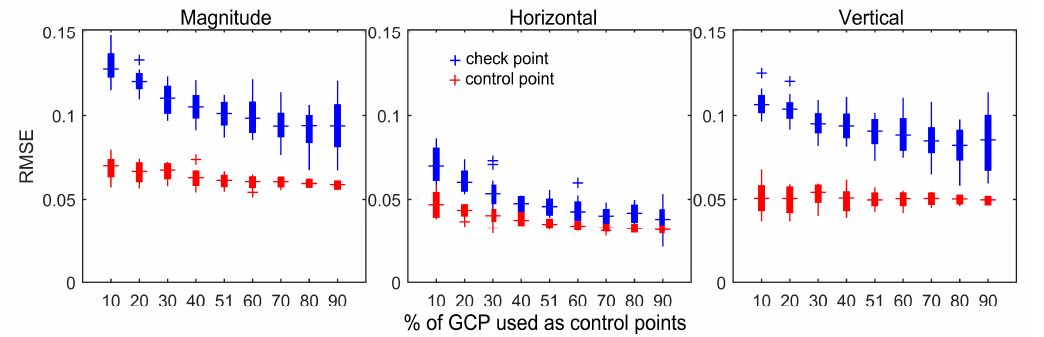
Figure 4. RMSE results for different numbers of control points.